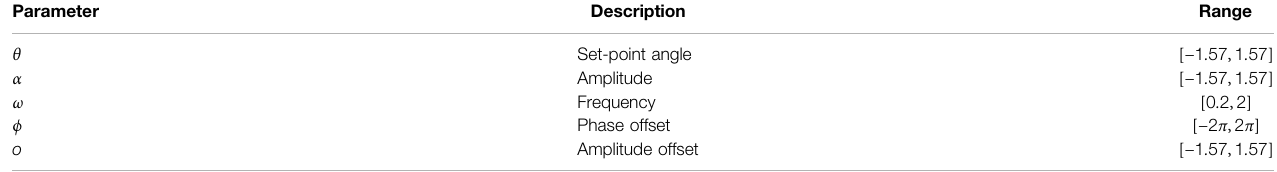
Table A2 | Parameters for the decentralized wave pattern controllers. The value ranges are based on the servo used in the real world modules.